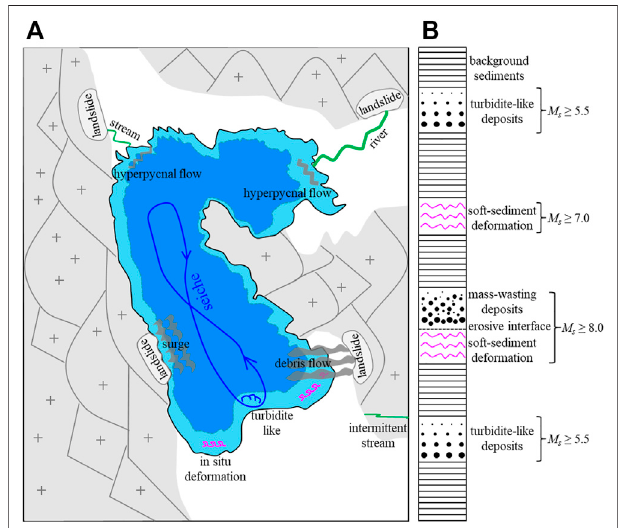
FIGURE 6 | A conceptual model showing (A) sedimentary processes in response to seismic shaking and (B) earthquake imprints on a sediment core from the nearshore zone of the lake. Mass-wasting deposits include sediments transported by debris fl ows and hyperpycnal fl ows.